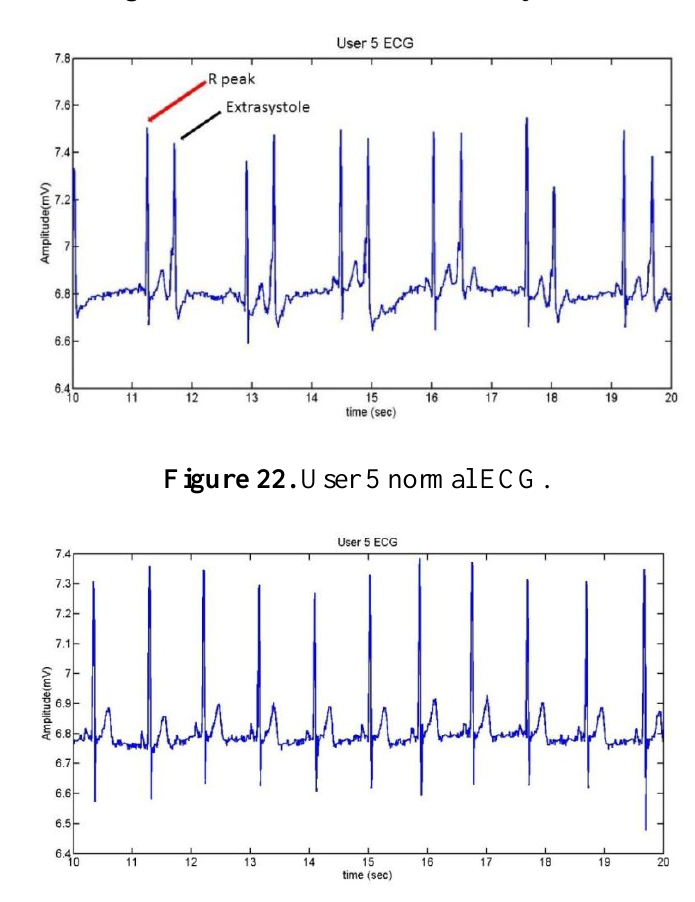
Figure 21. User 5 ECG with extrasystoles.